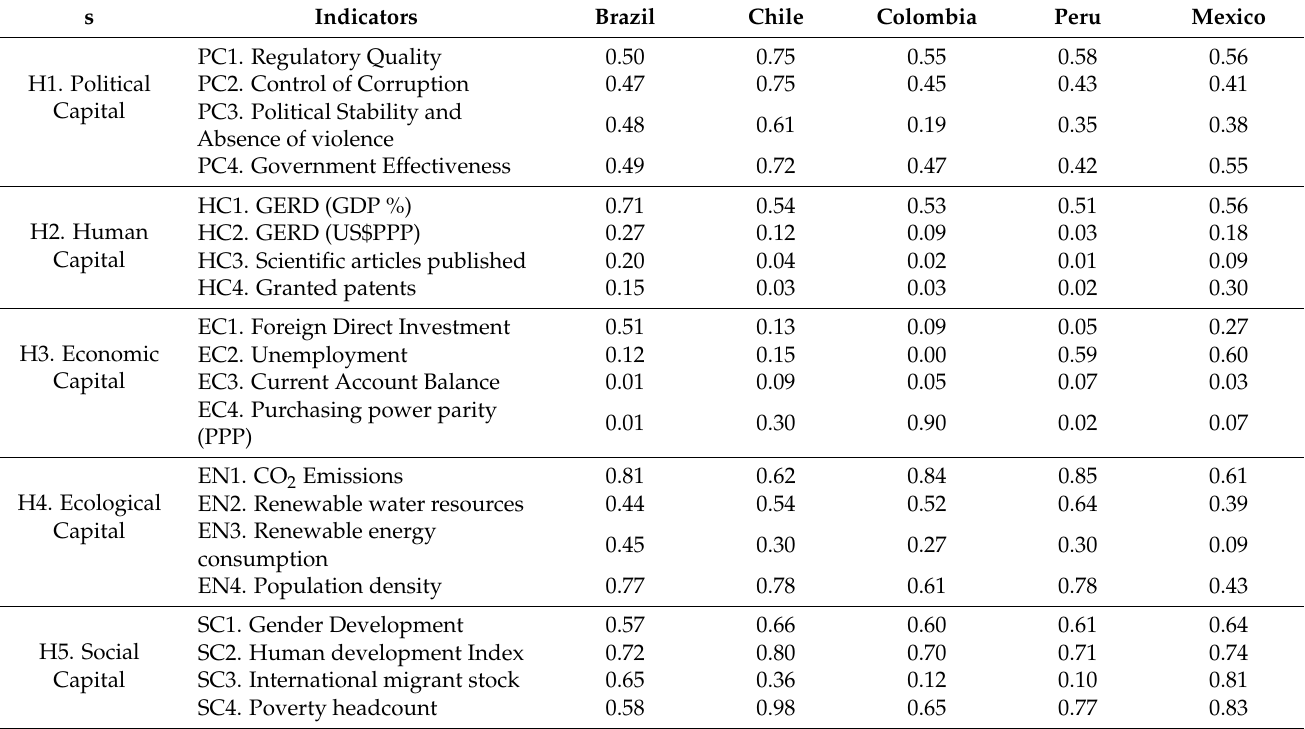
Table A3. Results of QHIM indicators.